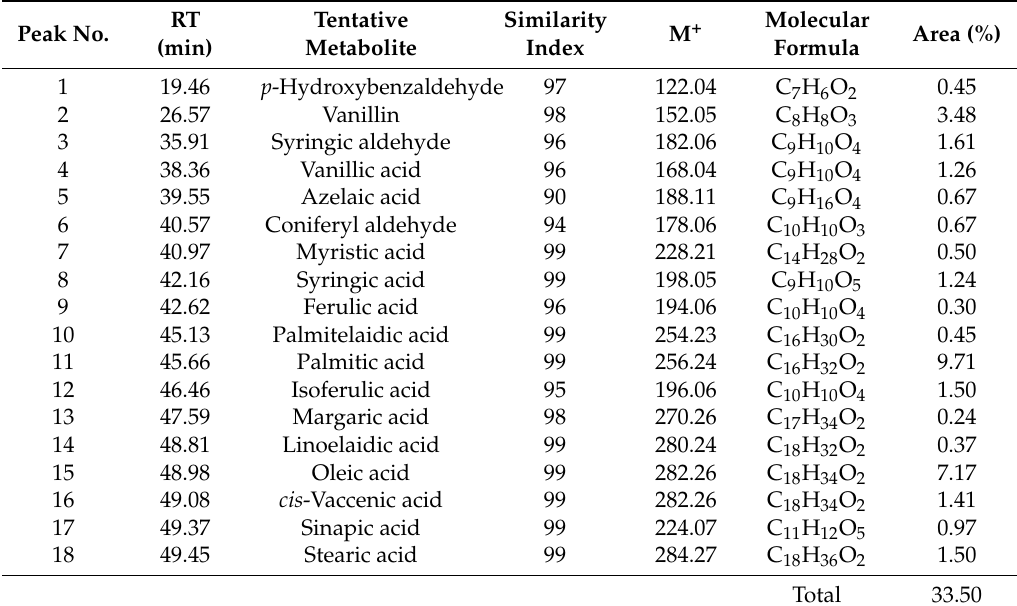
Table 4. Metabolites identified in the D. indum exocarp dichloromethane (DCM) fraction (EDF) through GC-MS analysis.